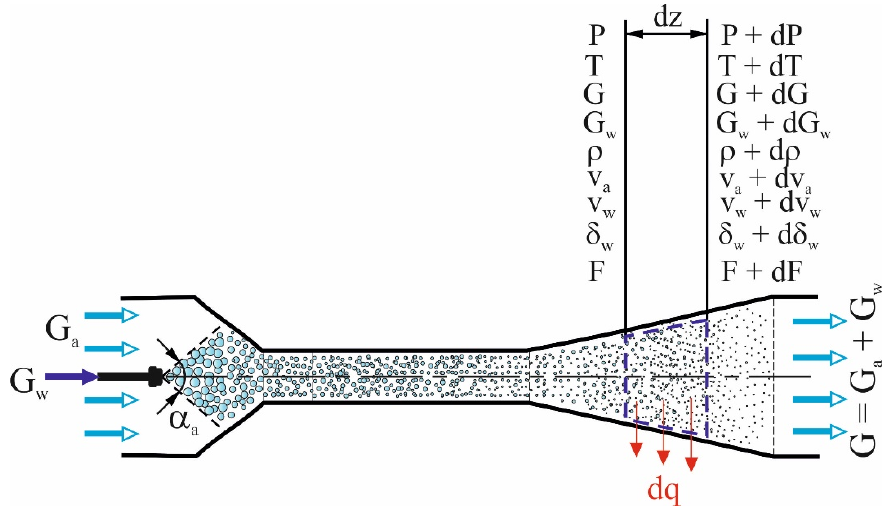
Figure 2. Changes in the parameters of the dispersed flow involved in the thermo-gas-dynamic compression process at the local section of the thermopressor flow path.